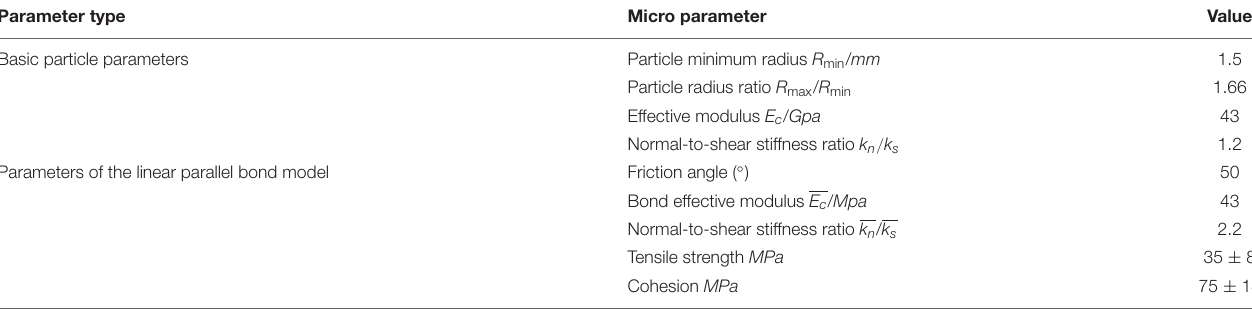
TABLE 2 | Microscopic parameters of the simulated numerical model.